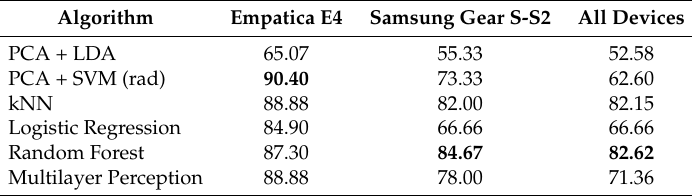
Table 8. Effect of the device used to three-class stress level classification accuracy when only heart activity signal is used (without